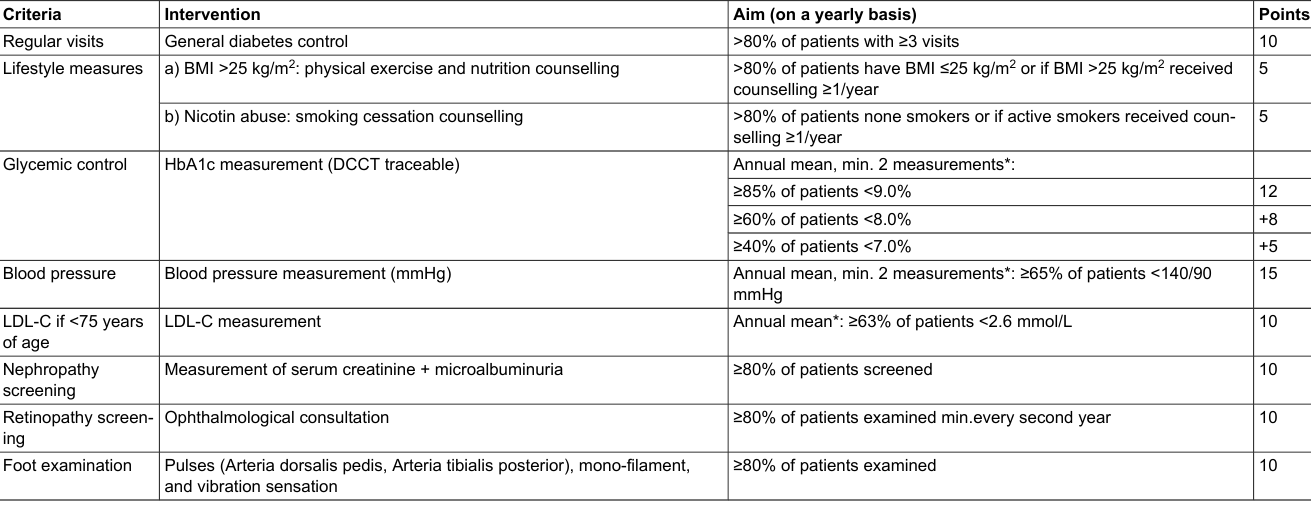
Table 1: The scoring system of the criteria for good disease management of diabetes. This score includes eight criteria for good diabetes disease management (three measurements and five diabetes-specific counselling or clinical assessments). The score is based on the diabetes recognition programme from the USA adapted for Switzerland. It was estab- lished by a working group of the Swiss Society of Endocrinology and Diabetology in collaboration with the Swiss Association of General Internal Medicine. The table lists the eight criteria of good diabetes care management and the scoring system to be used for evaluation on an individual practice level. The points allocated to each criteria are re- ceived when the patient-population aim is fulfilled. The goal is to achieve ≥70/100 points. The table is a modification of the 2017 publication of the criteria. Criteria Intervention Aim (on a yearly basis) Regular visits General diabetes